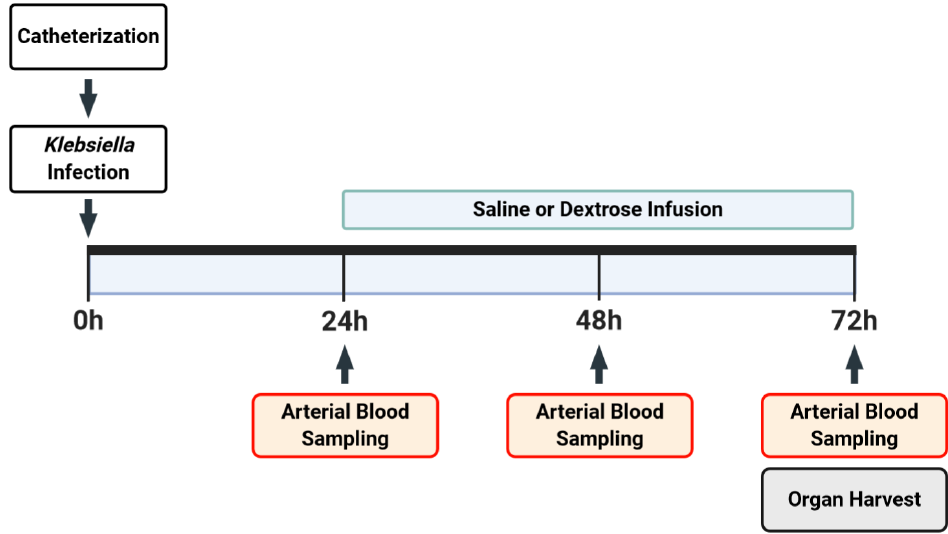
Figure 1. Experimental protocol. All mice ( n = 31) received femoral arterial catheterization accompanied by either femoral venous catherization or gastric cannulation, followed immediately by inoculation with oropharyngeal Klebsiella pneumoniae . Study infusion was started 24 hpi. Arterial blood was sampled every 24 h for assessment of glucose, insulin, and cytokine levels.